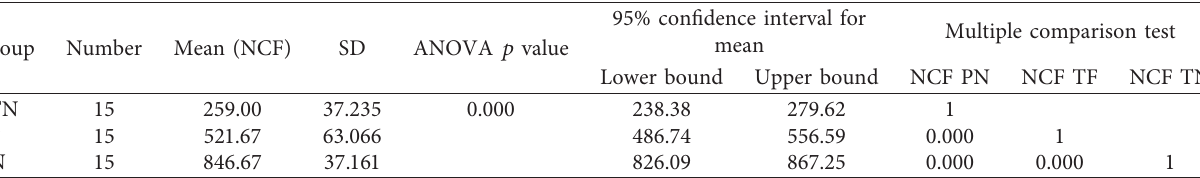
Table 1: Mean and SD of NCF of the three compared groups. ANOVA showed a significant p value ( p < 0 . 05). Tukey’s multiple comparison test results are